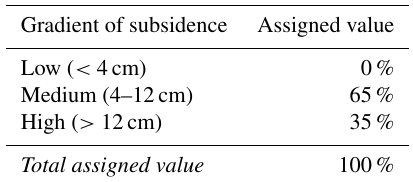
Table 1. Rated values for the gradient of subsidence ( g s ) in Mexico